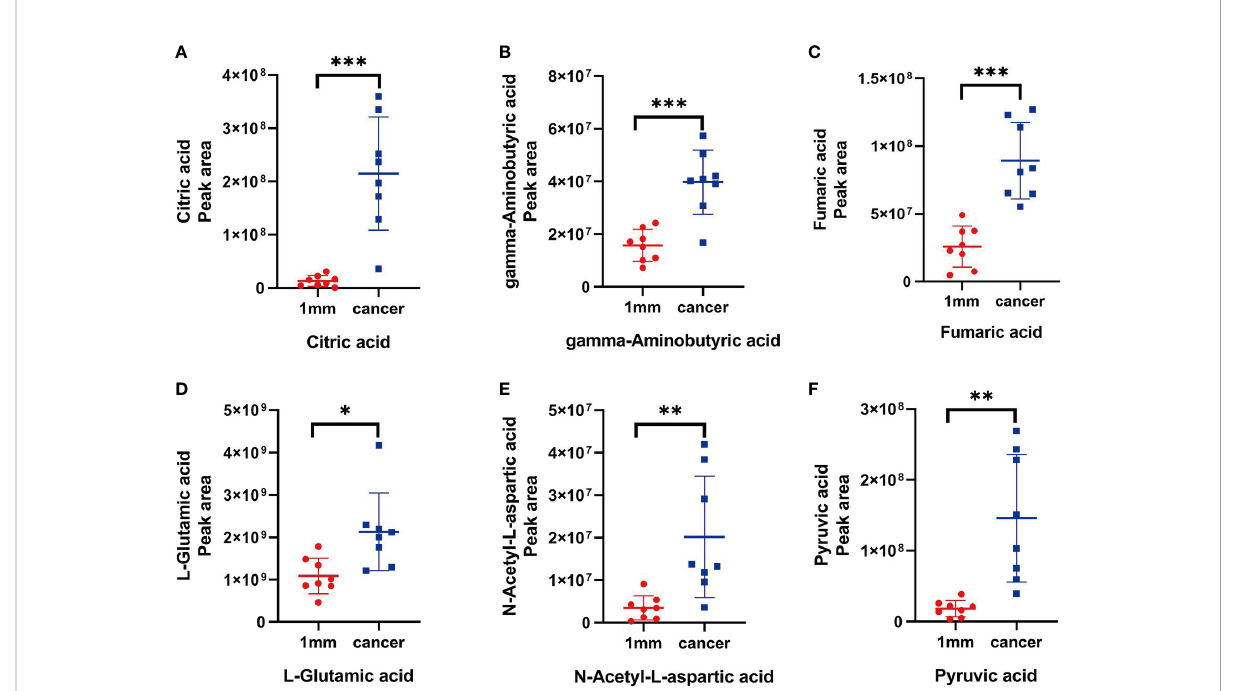
FIGURE 7 (A-F) The peak areas of citric acid, gamma-aminobutyric acid, fumaric acid, L-glutamic acid, N-acetyl-L-aspartic acid and pyruvic acid in tissue located at the 1 mm surgical margin and tumor tissue, with signi fi cant differences (P < 0.05)."*" stands for the p < 0.05,"**" stands for the p < 0.01, "***" stands for the p <